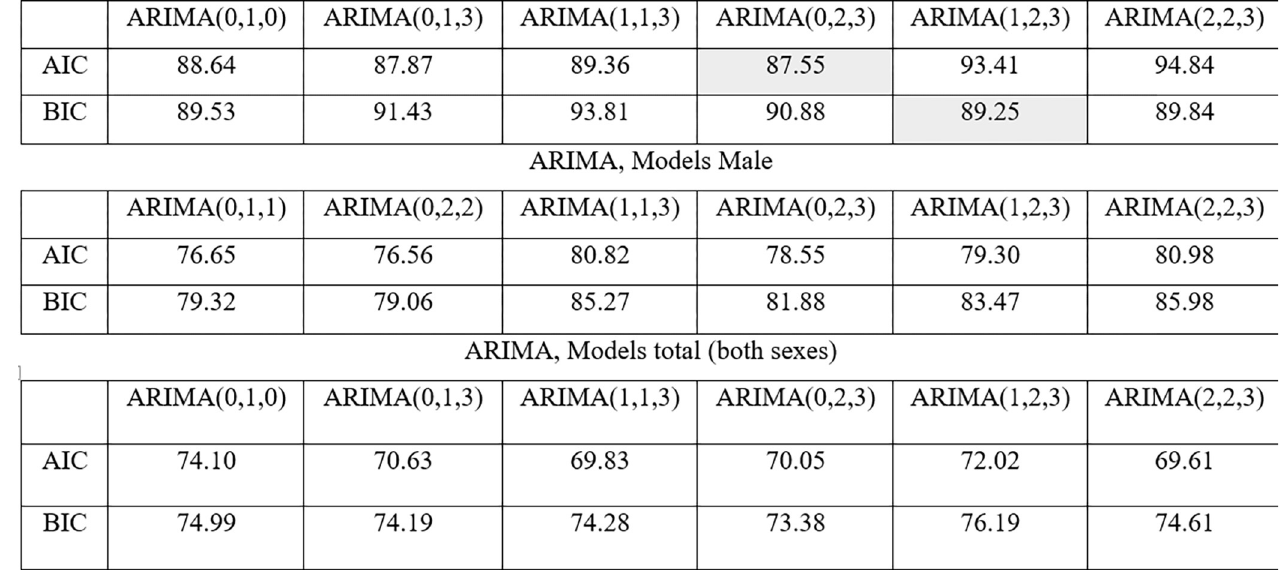
Fig 15. ARIMA models, male, female and both genders.